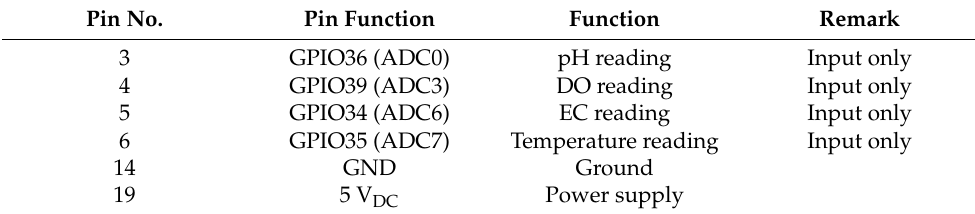
Table 4. Pin assignment of ESP32 Wi-Fi module for proposed multi-sensor system. Pin